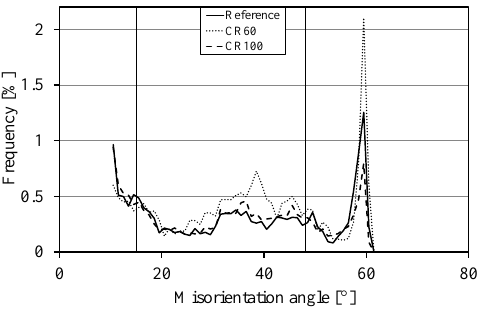
Figure 2. The frequency of parent austenite boundaries for all samples versus the misorientation for martensite boundaries.